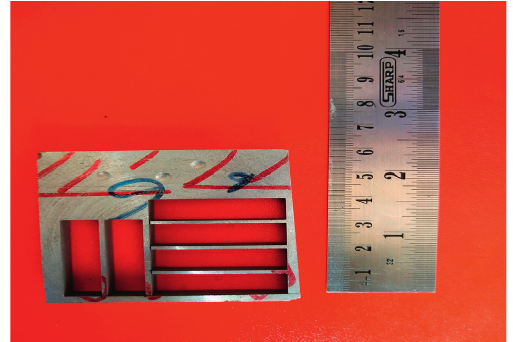
Figure 1: Wire electrical discharge machined AA5083-MoO sample.